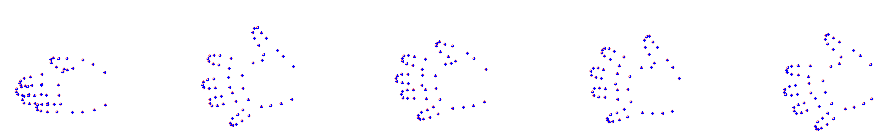
Figure 7. Registration results on some examples on the IMM hands dataset of person 2. The first row is the original image of gesture 1, and the annotated landmarks are employed as model point set. The second row and fifth row are the original images from gesture 2 to gesture 5 and gesture 6 to 10, respectively. Their annotated landmarks are employed to the scene point sets. The third and sixth rows are the point sets to be registered and the fourth and seventh rows are the registration results. The model points are marked by “ +, ” and the scene points are marked by “ o. ”